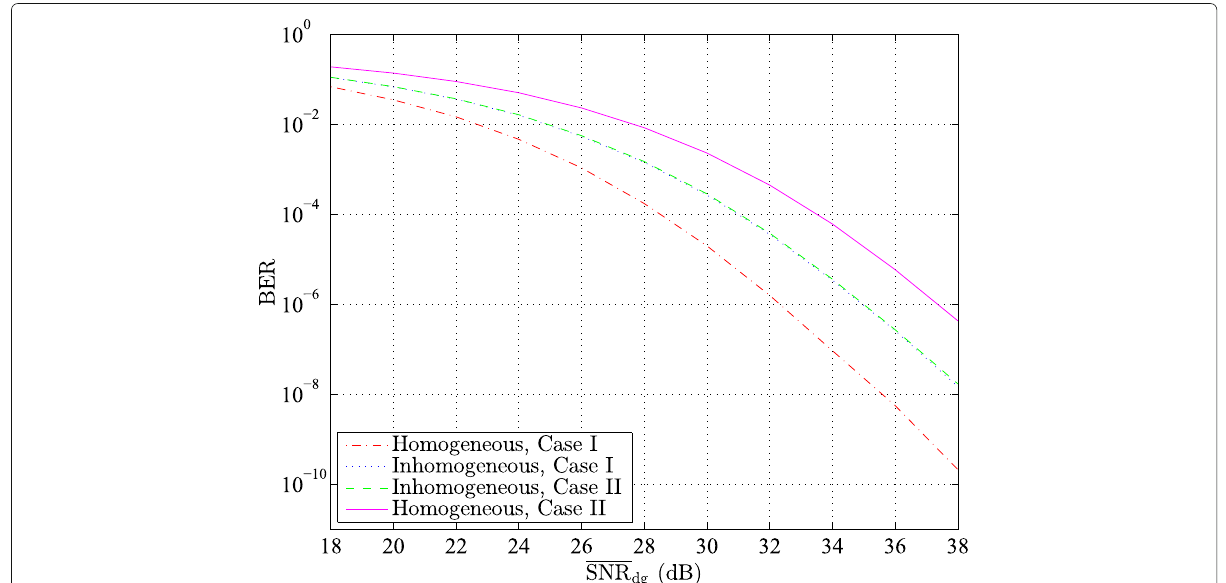
Fig. 9 BER versus designed SNR: comparison between homogeneous distributions and inhomogeneous distributions for large scale fading coefficients { g ij